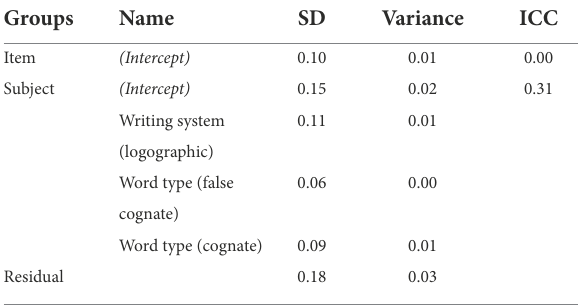
TABLE 3 Random effects from linear mixed model of score with item and subject as random effects in the production tasks.